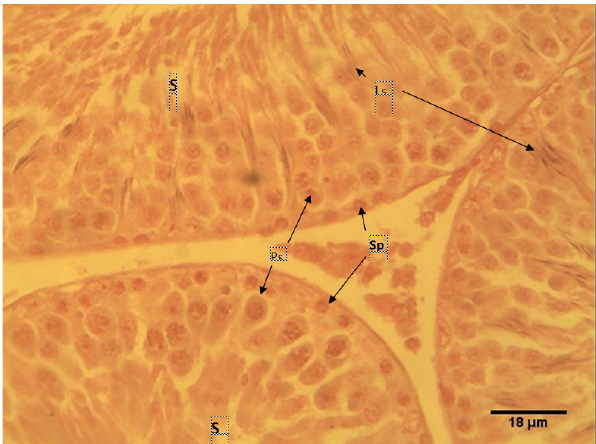
Fig. 3. Histological appearance of testis of rat given 0.5 mg/kg body weight of quail egg orally for 63 days, showing no obvious lesions. Note active seminiferous tubules (S) and interstitium